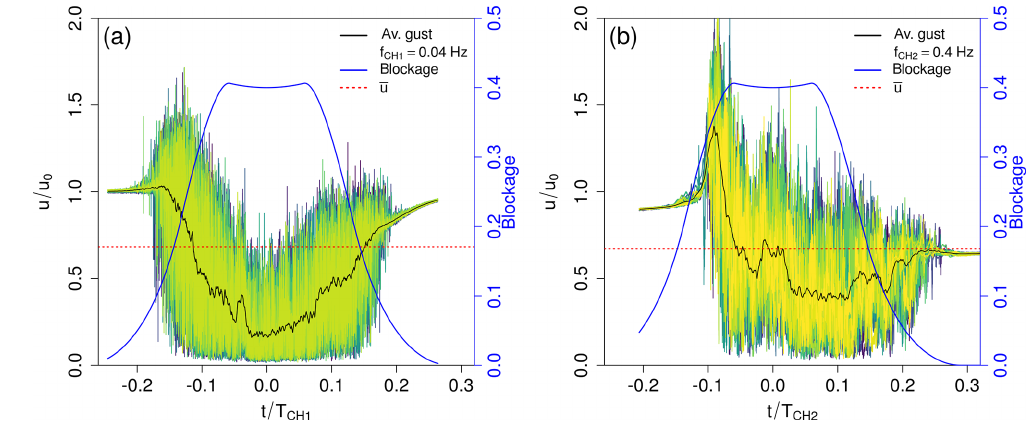
Figure 11. Plot of all inverse gusts captured in the time series measured at the centerline 5.425 w CH downstream of the chopper blade for a = 0 . 04Hz and (b) f = 0 . 4Hz. In different colors (dark blue–green–yellow color map), the inverse gust chopper frequency of (a) f CH CH 2 1 events are plotted, in black the smoothed average inverse gust is marked, and in blue the blockage is added with the corresponding axis on the right side.